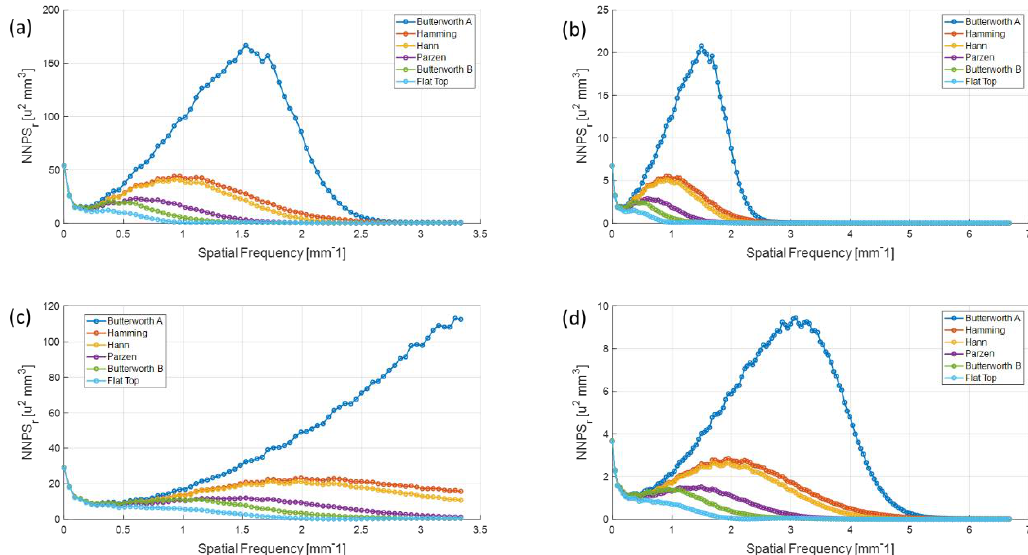
Figure 12. Radially averaged 1D NPS for each configuration from ( a ) (1, 1), ( b ) (1, 2), ( c ) (2, 1), and ( d ) (2, 2) with different filter